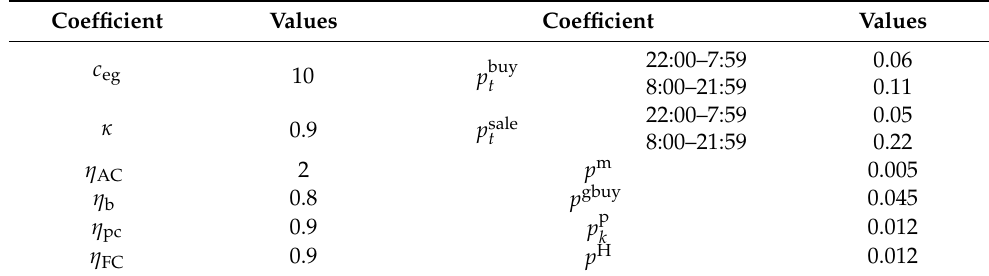
Figure A2. Day-ahead load forecast. Table A1. Values of coefficients in the case study.